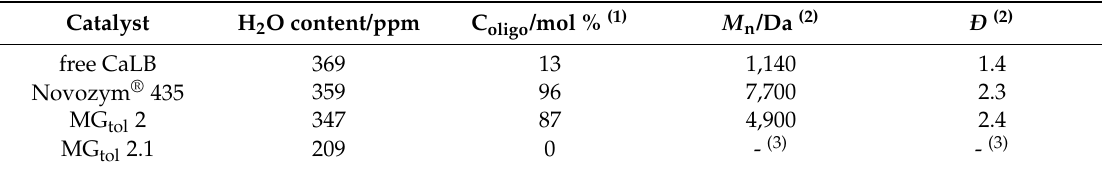
Table 4. Enzymatic ROP of ε -CL in toluene using free and immobilized CaLB as catalyst; results of NMR and SEC analyses.